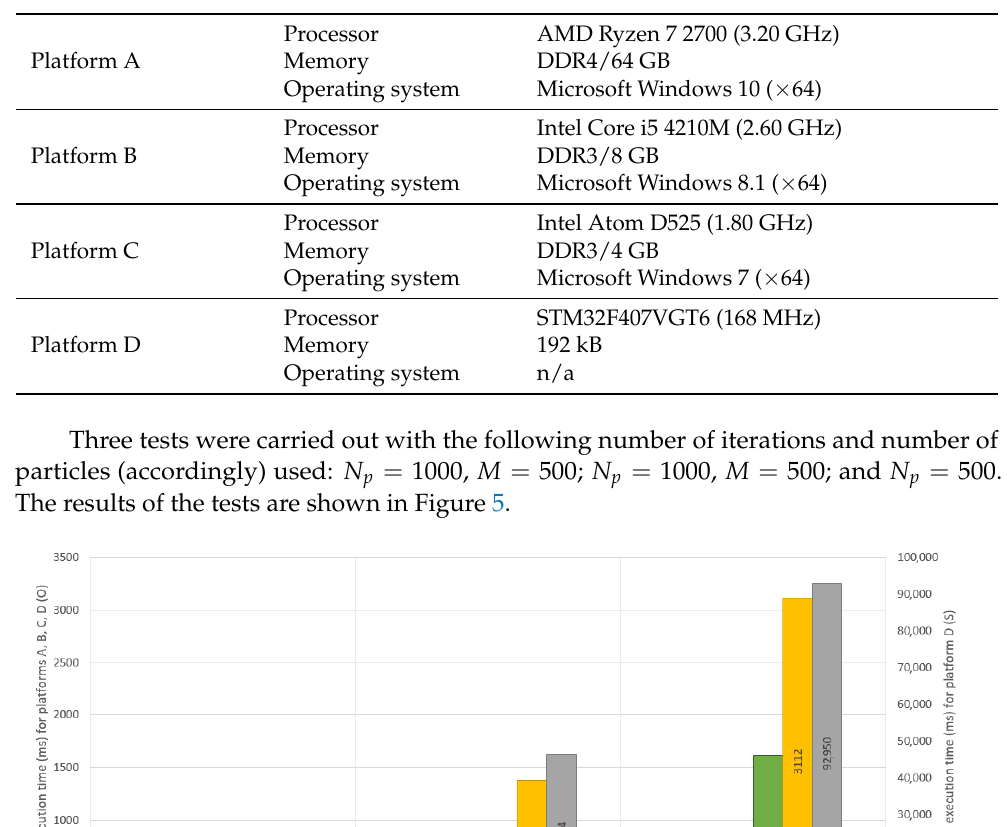
Table 1. Specification of the hardware platform used in the experiments.